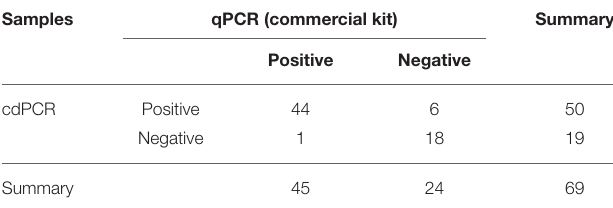
TABLE 3B | Testing of clinical samples by cdPCR and commercial